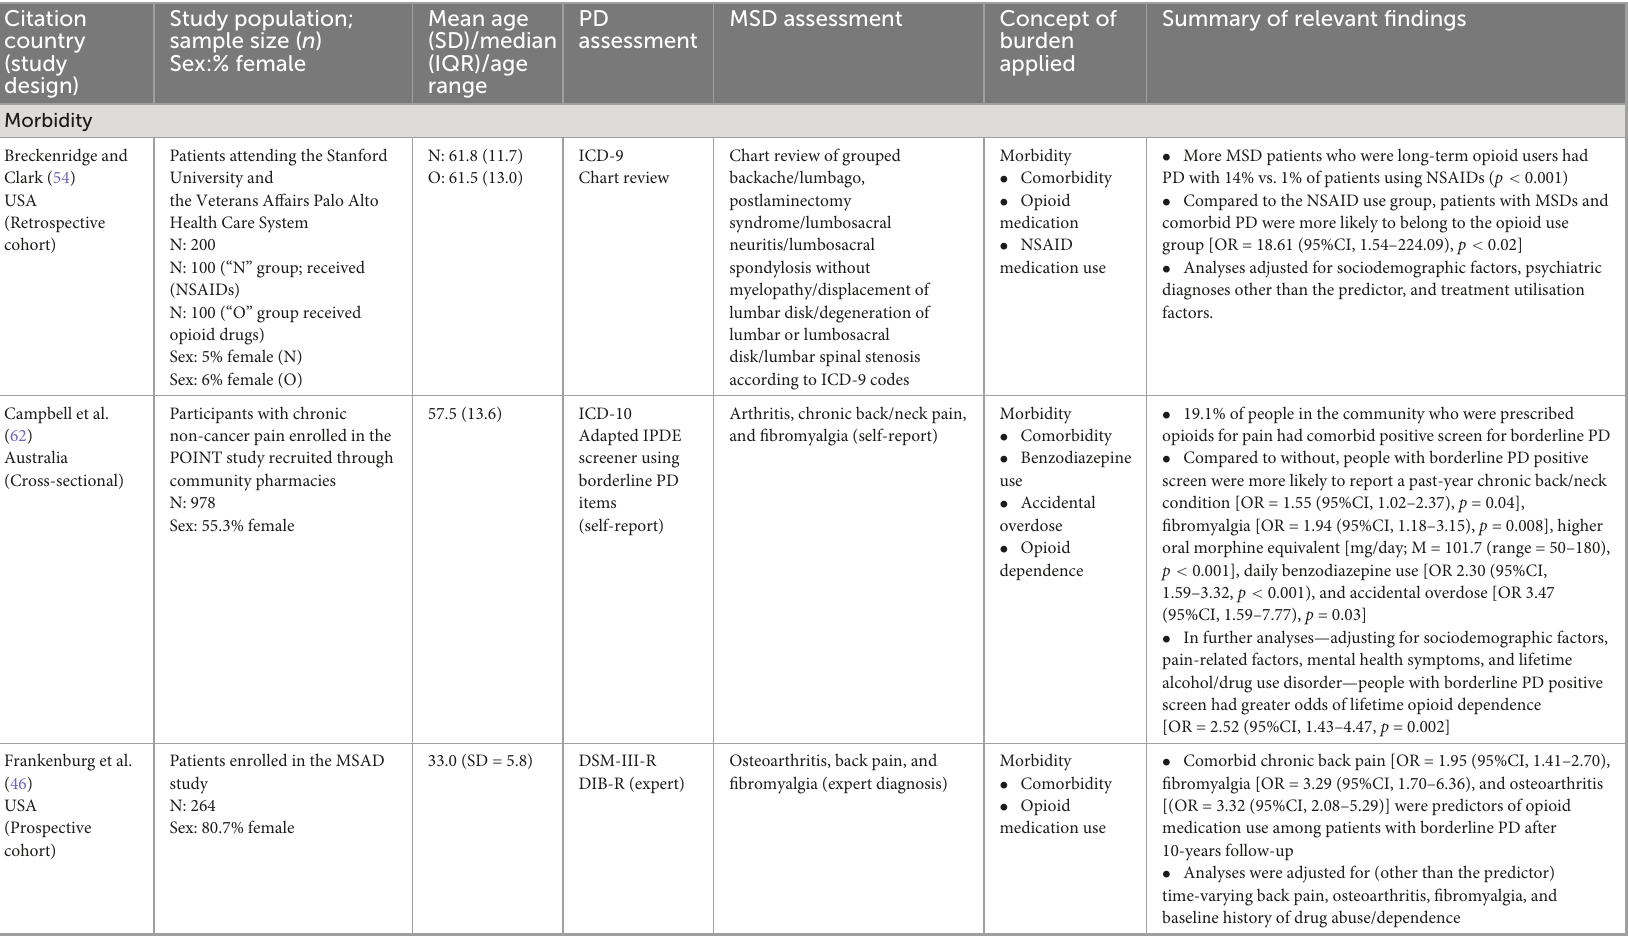
TABLE 2 Summary of relevant findings on the burden associated with the comorbidity of PDs and MSDs, according to identified concepts and citation. Citation